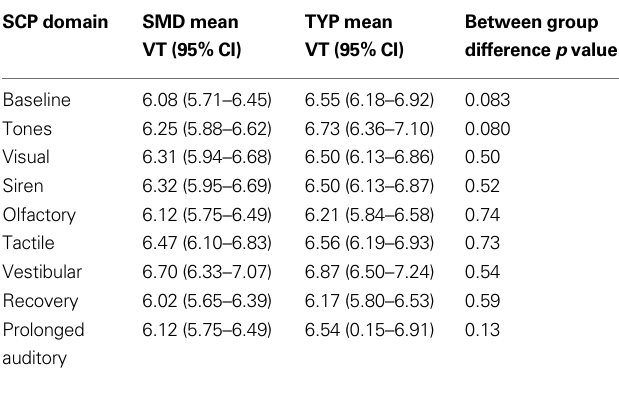
Table 1 | Age-adjusted mean VT values for SMD and TYP groups during